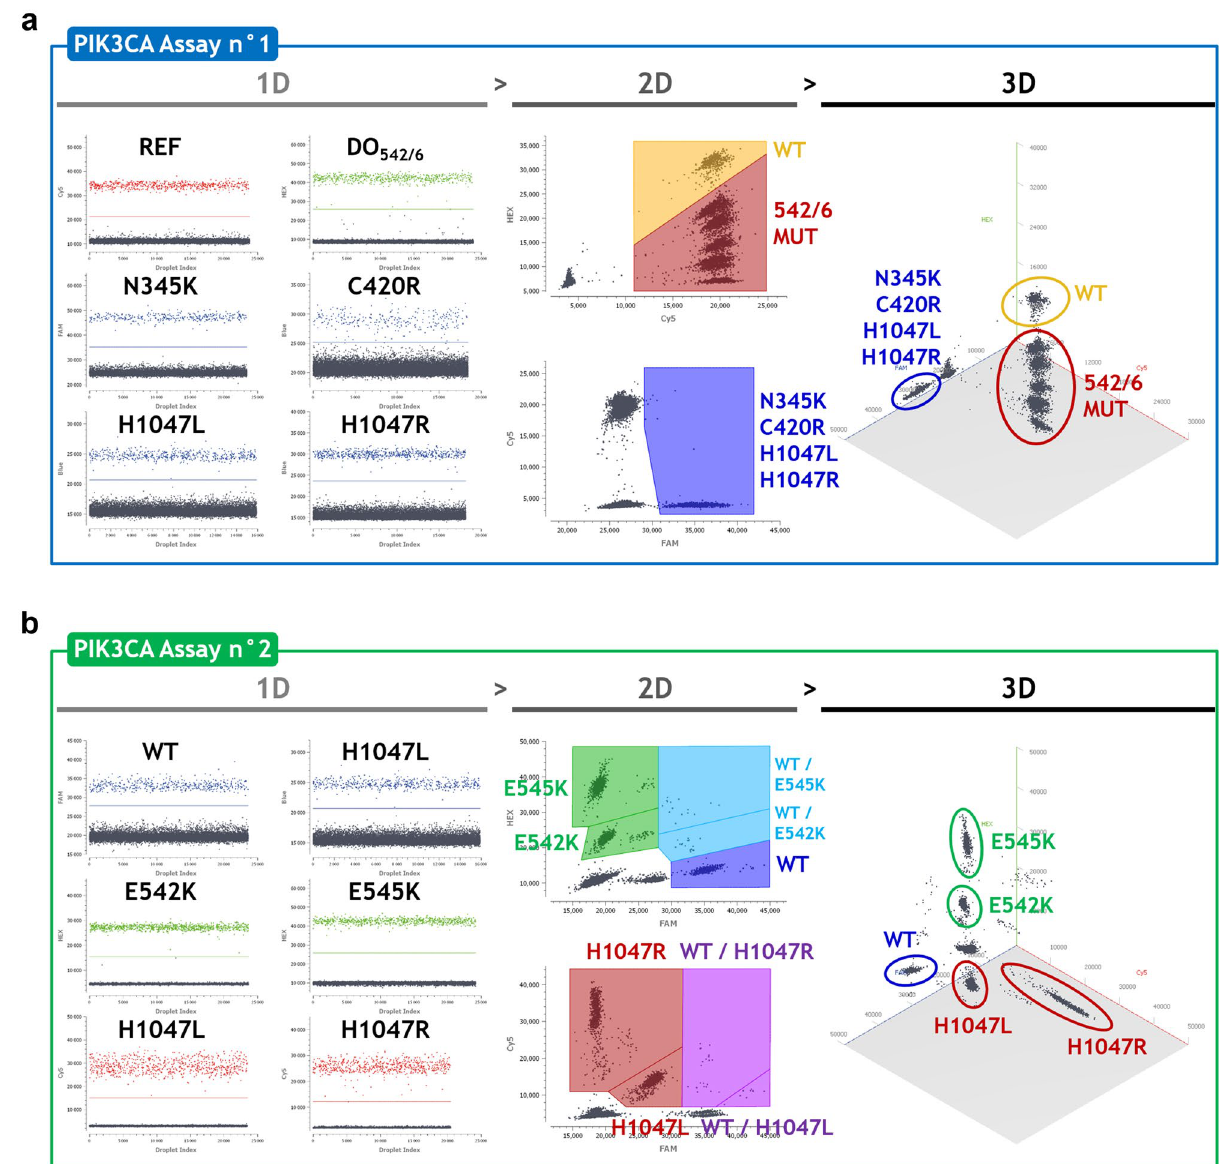
Figure 2. Optimization and quantification strategies for the PIK3CA assays. ( a ) PIK3CA Assay n°1: ‘1D’ left panel showing optimized fluorescence signals produced by each probe in a simplex reaction; ‘2D’ center panel showing the polygon gating quantification strategy defined using a mixture of WT gDNA and MUT gBlocks for N345K, C420R, E542K, E545A/G/K/Q, Q546K/P/R and H1047L/R mutations; ‘3D’ right panel showing the cluster positions according to their relative FAM-HEX-Cy5 fluorescence signals. ( b ) PIK3CA Assay n°2: ‘1D’ left panel showing optimized fluorescence signals produced by each probe in a simplex reaction; ‘2D’ center panel showing the polygon gating quantification strategy defined using a mixture of WT gDNA and MUT gBlocks for E542K, E545K and H1047L/R mutations; ‘3D’ right panel showing the cluster positions according to their relative FAM-HEX-Cy5 fluorescence